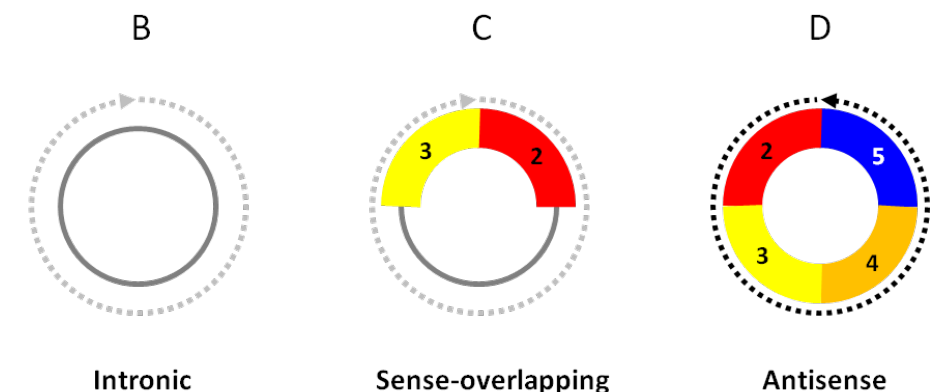
Figure 1. Structural categories of circRNAs. ( A ) Exonic circRNAs consist of only exons. ( B ) Intronic circRNAs consist of only introns. ( C ) Sense-overlapping circRNAs consist of exons and introns. ( D ) Antisense circRNAs are in strand direction antisense to their linear RNA counterparts. The exon numbers are for illustration only.